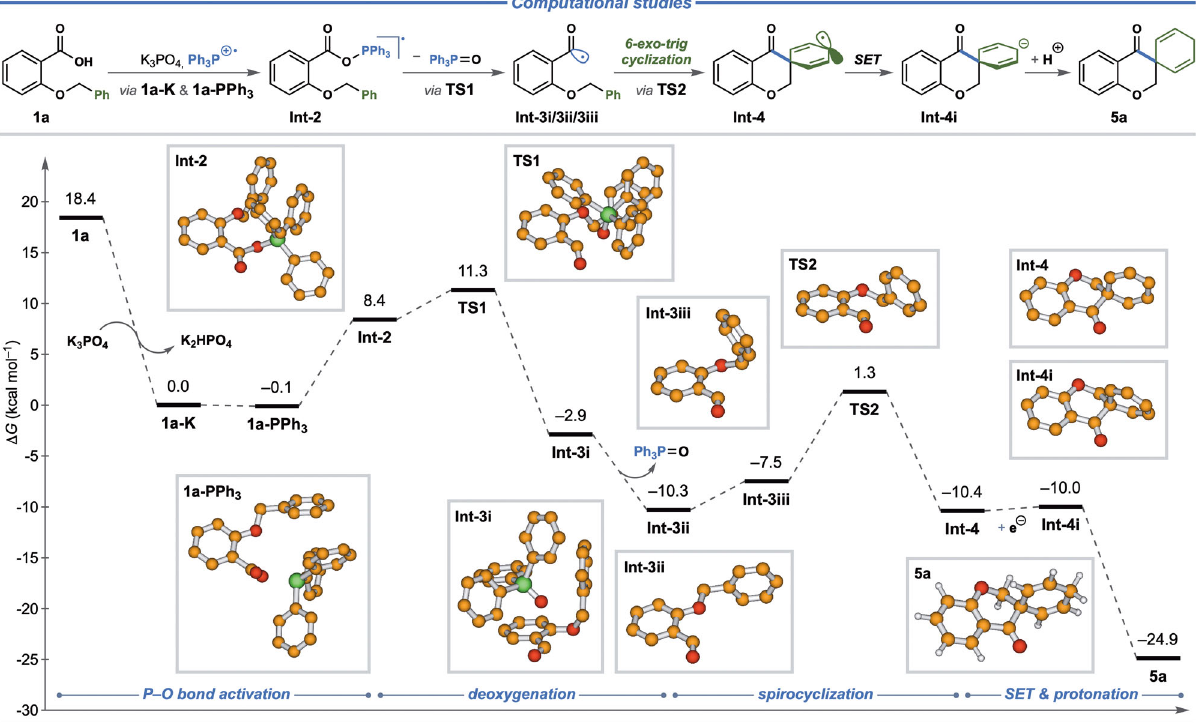
Fig. 6 Mechanistic studies. DFT-investigation of the dearomatization mechanism at the B3LYP/6-311 + G(d,p) – D3 – CPCM(acetonitrile, UFF) level of